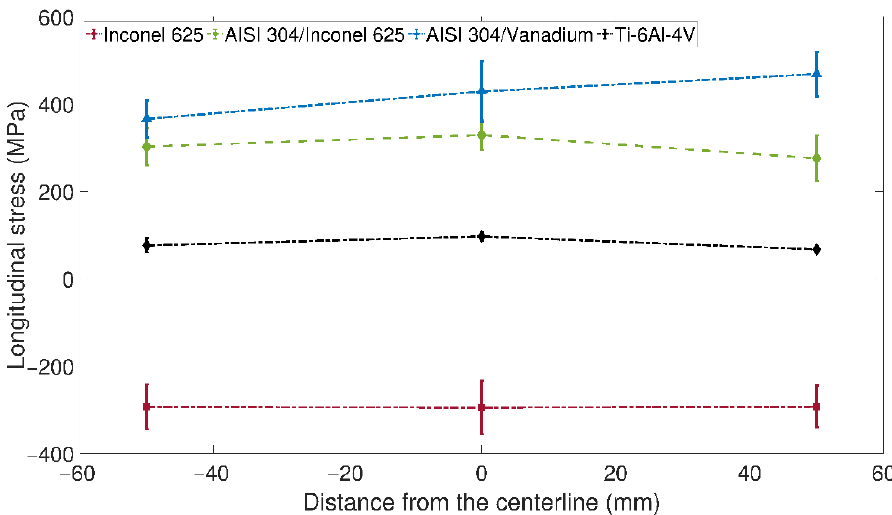
Figure 4. Surface longitudinal residual stresses measured by X-ray diffraction (stresses are in MPa).